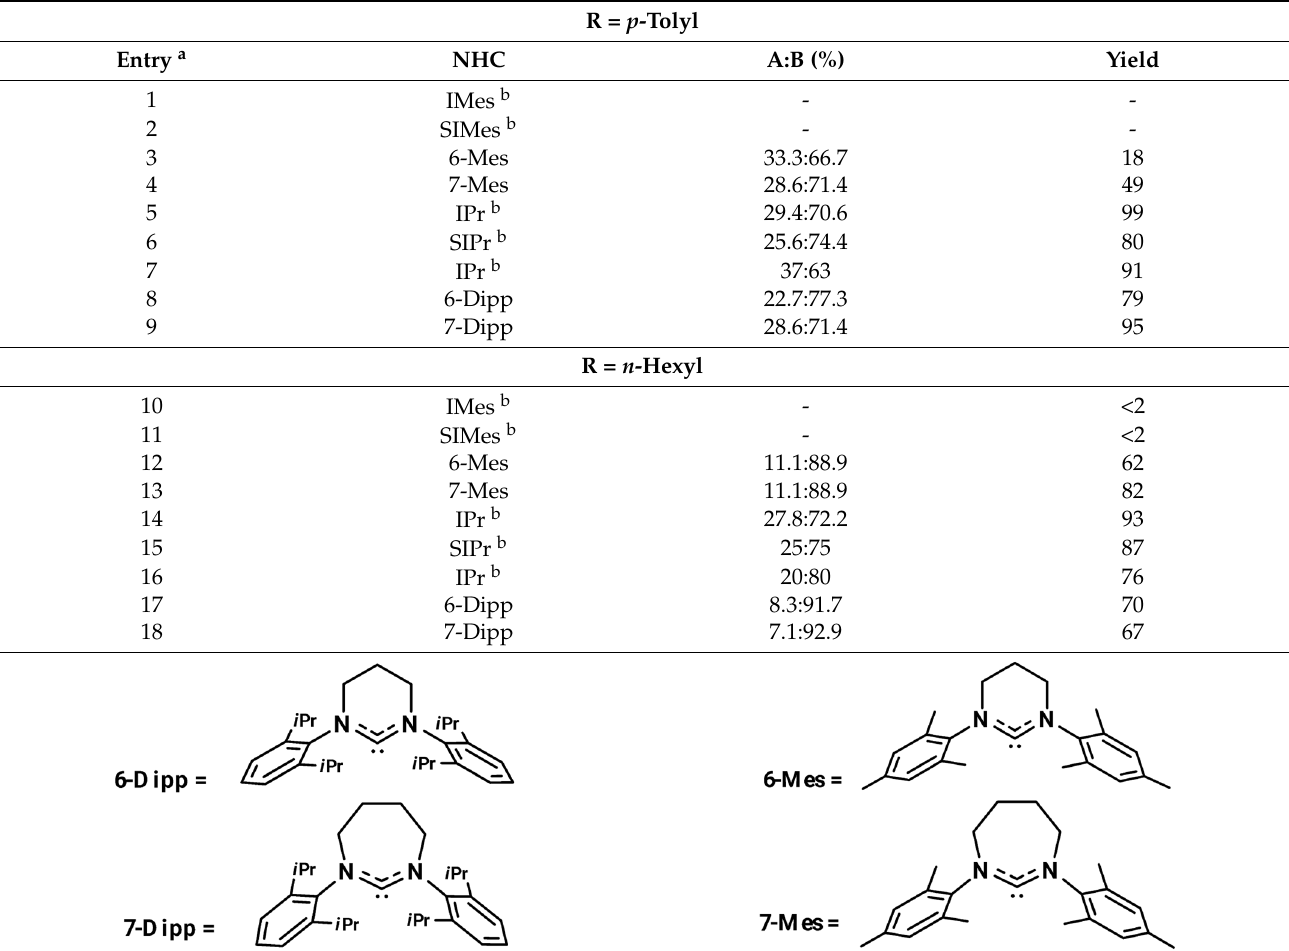
Table 21. Results of Au(I) NHC precatalysts with different ring size. R = p -Tolyl